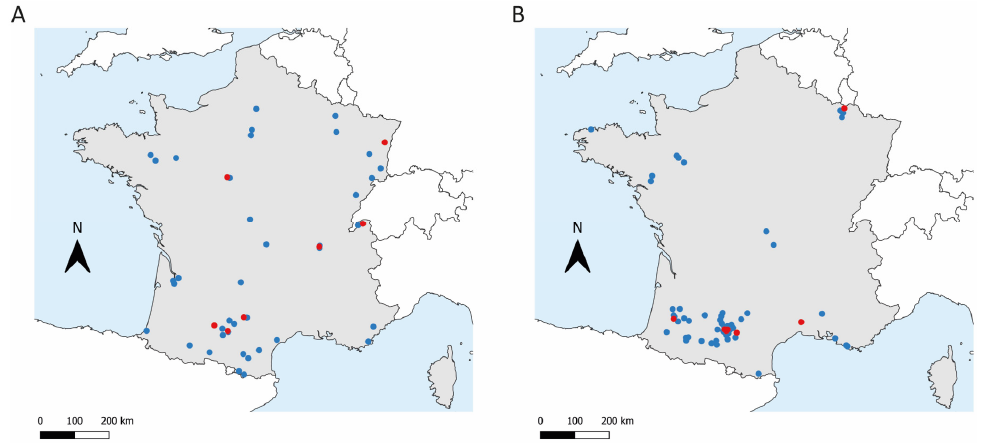
Figure 1. Spatial distribution of the feline ( A ) and canine ( B ) sample locations. Blue dots indicate samples that were negative for anti-SARS-CoV-2 antibodies. Red dots indicate samples that were positive.